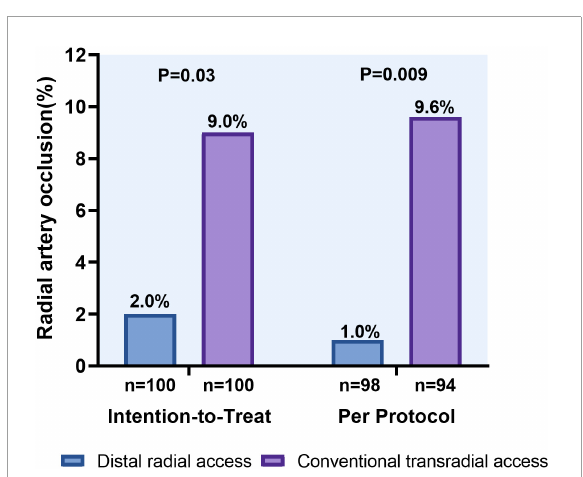
FIGURE5 Forearm radial artery occlusion rates using the distal versus conventional transradial access.